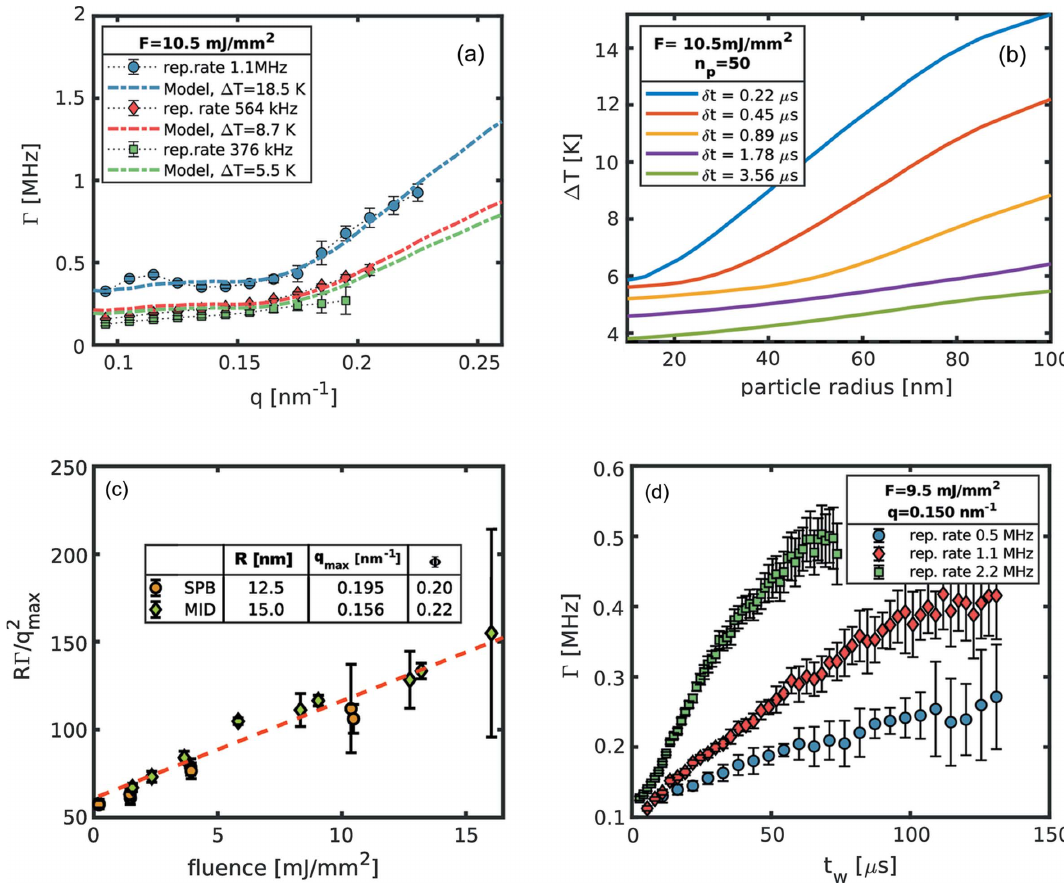
Figure 6 Possible strategies to control the beam-heating effect. ( a ) Relaxation rates from sample B are shown in three different configurations as indicated, the respective dashed lines are the average relaxation rate obtained from the time-resolved model. ( b ) Expected average temperature jump in a diluted colloidal sample of silica nanoparticles as a function of the particle radius for different repetition rates at a fluence of 10.5 mJ mm (cid:2) 2 and 50 pulses. ( c ) Rescaled relaxation rates after 15 pulses as a function of the fluence for the SPB/SFX and MID data. Once the differences due to the different particle size are removed, the diffusion constant follows the same linear behaviour for both systems, confirming the fact that the only changing quantity is the temperature in the scattering volume. ( d ) (cid:3) ( q *) for different waiting times at three different repetition rates measured at